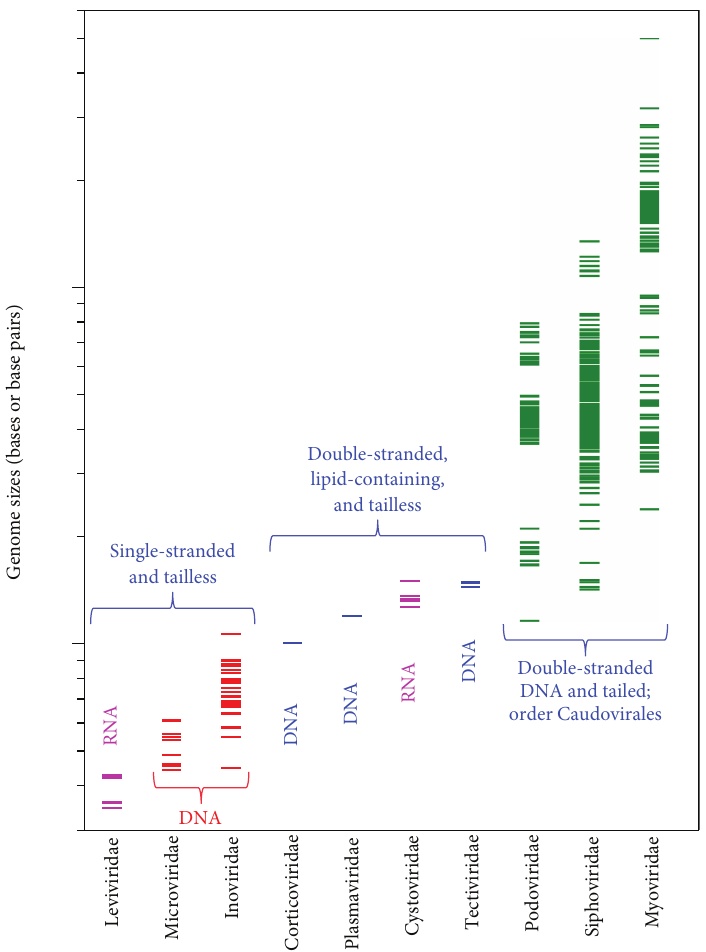
F 2: Comparison of phage genome sizes as differentiated by family. Genome sizes are as provided by NCBI (follow the Viruses link from http://www.ncbi.nlm.nih.gov/genome). Phage morphologies are provided also by NCBI but we defer to the International Committee for Virus Taxonomy given con�ict between the two (http://www.ictvonline.org/). In addition, there are older sequences along with one newer sequence (phage G) that are not yet found on the above NCBI database page that we have included. ese are for Enterobacteria phage